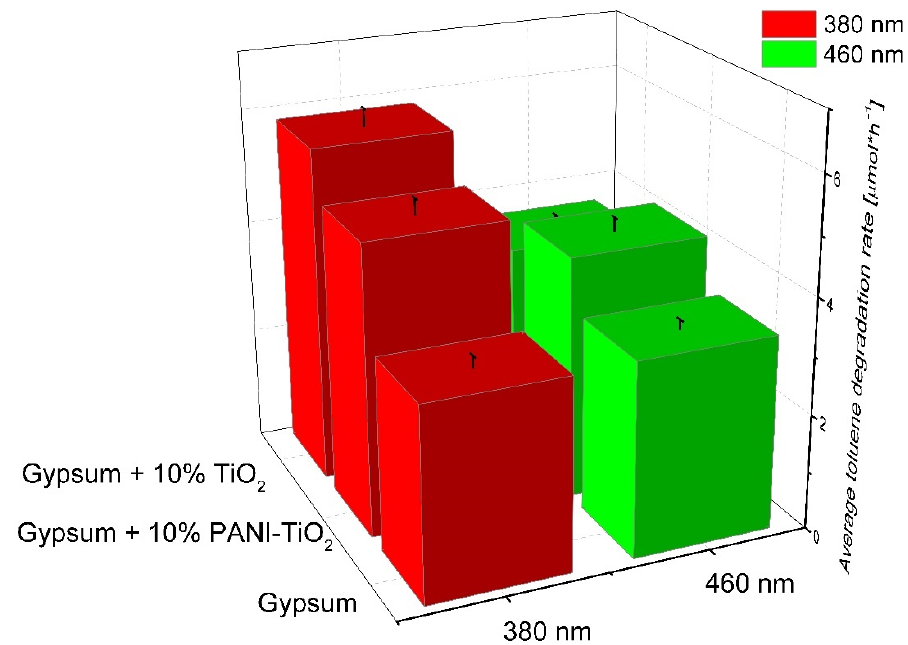
Figure 13. Toluene degradation in the presence of gypsum, gypsum loaded with TiO 2 , and gypsum modified with PANI–TiO 2. Irradiation time: 3 h, toluene initial concentration: 200 pm; photocatalyst mass: 15 mg